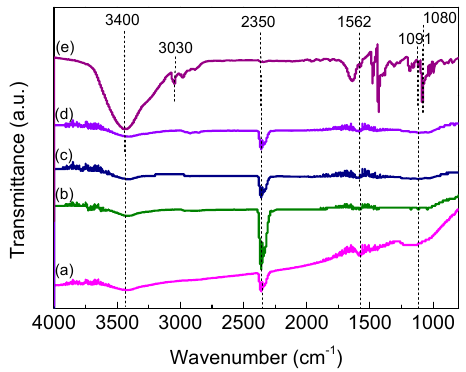
Figure 2. FT-IR spectra of: (a) Ru/AC, (b) Ф -P-Ru/AC, (c) Ф -P-Ru/AC-HCl, (d) Ф -P-Ru/AC-HNO 3 , (e) Ф -P-Ru. The characteristic peaks are centered at: 1080 cm − 1 : C–P; 1091 cm − 1 : C–OH; 1562 cm − 1 : COOH; 2350 cm − 1 : C ≡ N; 3030 cm − 1 : C–H; 3400 cm − 1 : phenolic hydroxyl.